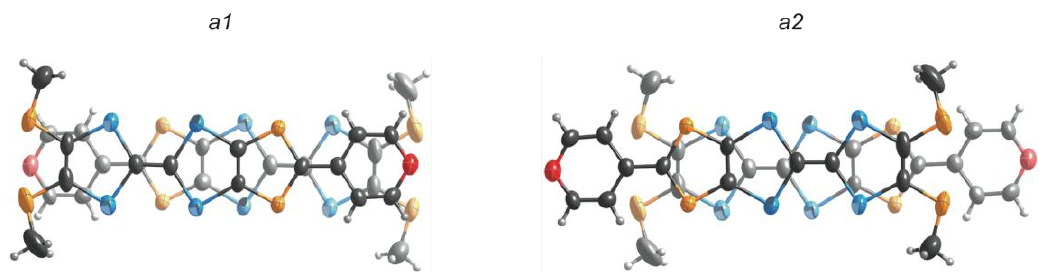
Figure 7. Molecular overlap modes for a1 and a2 of (TM-PDS-STP)PF atoms and bonds of the depth molecules are faded out.